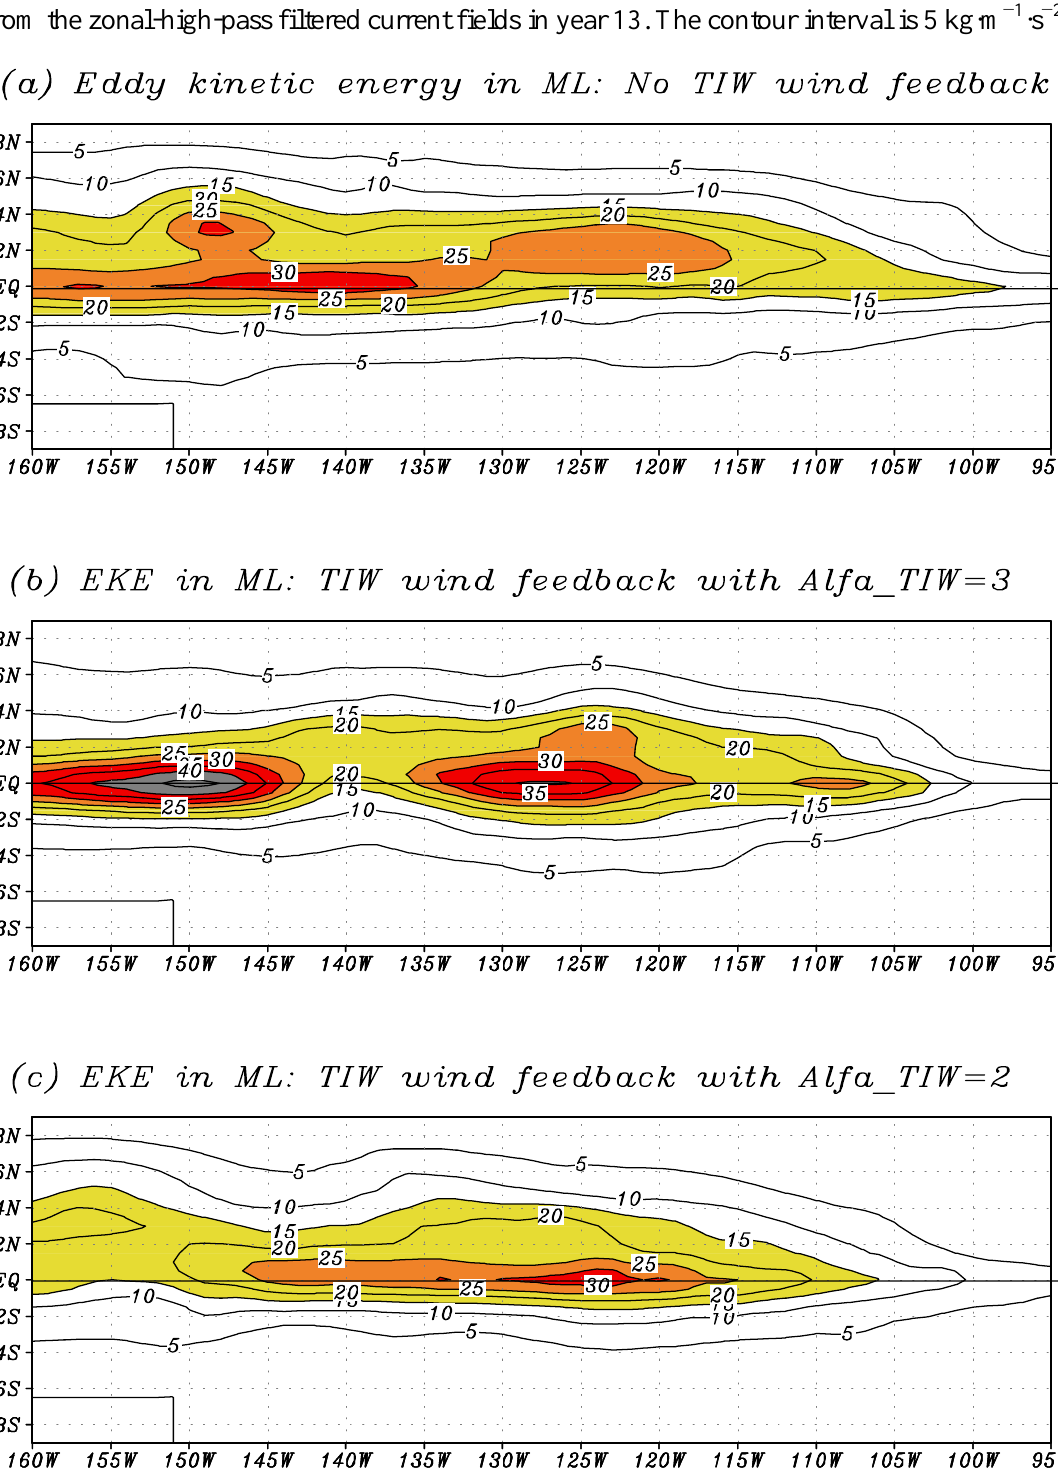
Figure 7. Horizontal distributions of the EKE calculated ( a ) from the no-feedback run and from the feedback runs with ( b ) α = 3.0 and ( c ) α = 2.0, respectively. The calculations are TIW TIW